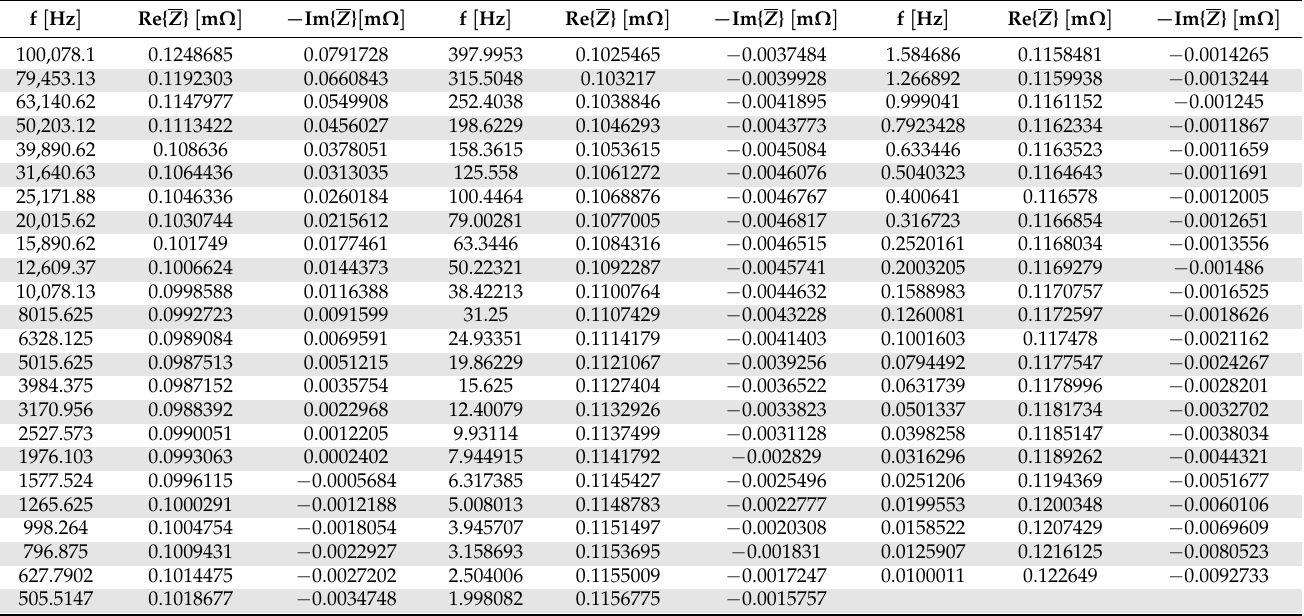
Table A1. EIS data for Keeppower P1834J at an SOC of